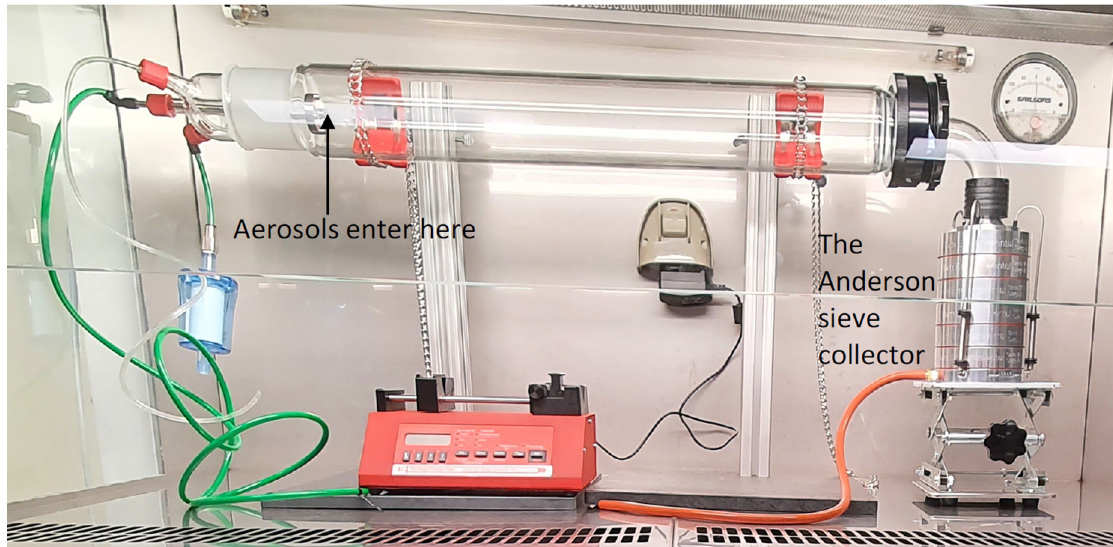
Figure 5. The bacterial filtration efficiency rig containing an Anderson sieve sampler. Aerosols of 3.0 ± 0.3 µ m on average of viruses, bacteria or fungal spores were produced in the